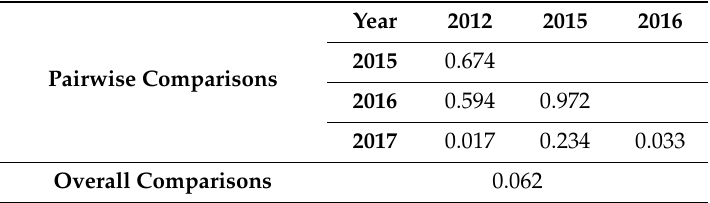
Table 7. Breslow tests (overall and pairwise comparisons) per year regarding